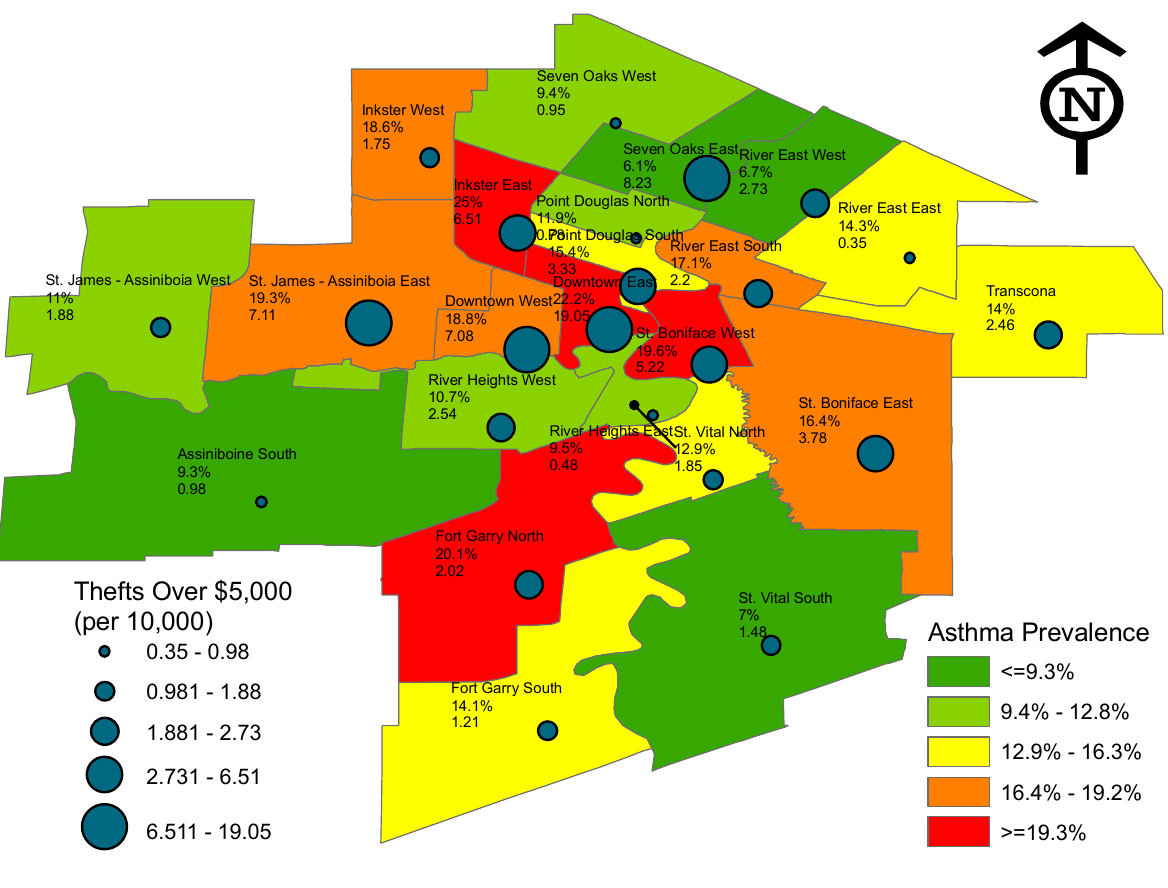
Figure 1. Asthma prevalence of birth and non-birth home children at age 7 or 8 and the annual incidence of thefts over $5,000 in Winnipeg by neighbourhood